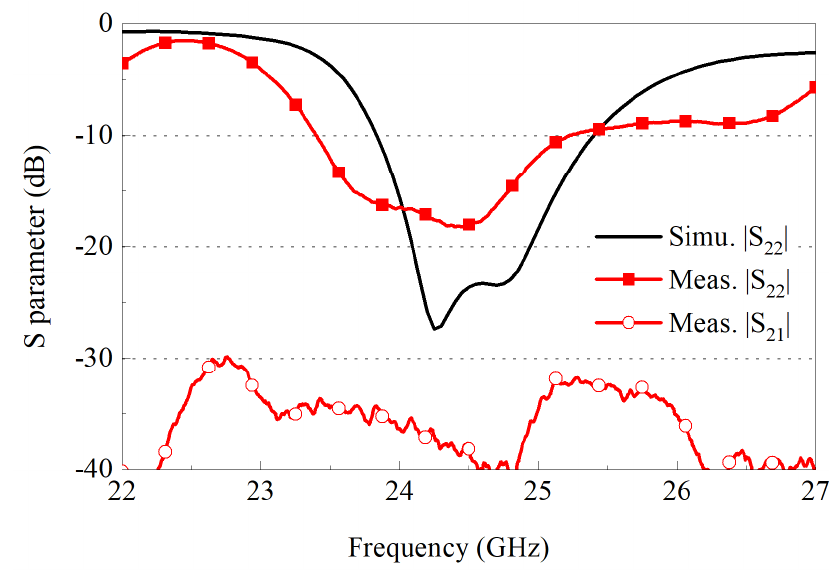
Figure 13. Simulated and measured S parameters in the upper frequency band.